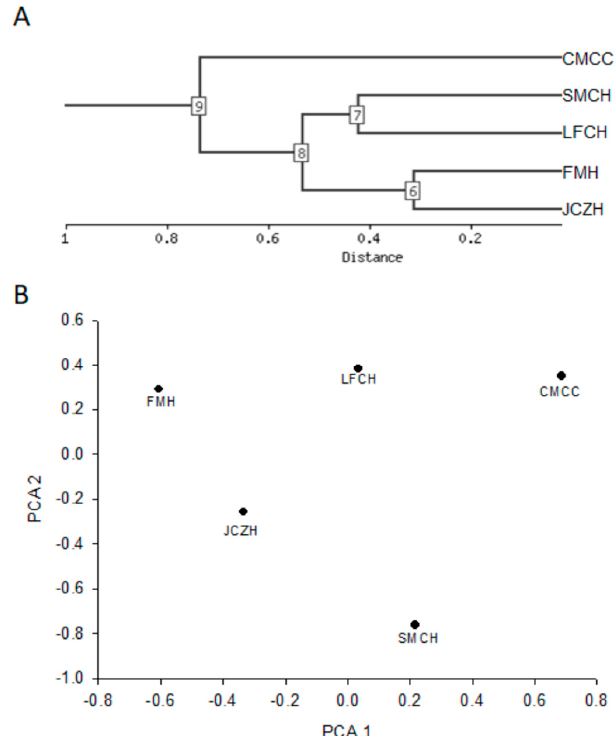
Figure 3. Associations between morphology and chemical composition of pine nut from five population of P. cembroides by hierarchical cluster analysis ( A ) and PCA ( B ), using the National Institute on Aging (NIA) array analysis tool. Population names are indicated in Table 4.